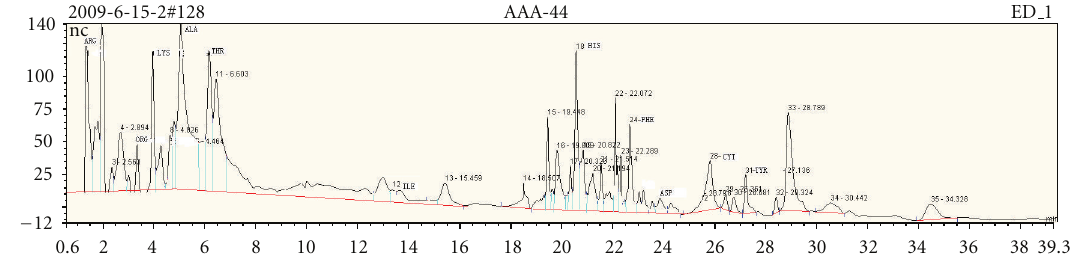
Figure 3: Total ion current of a gastric cancer inpatient urine.